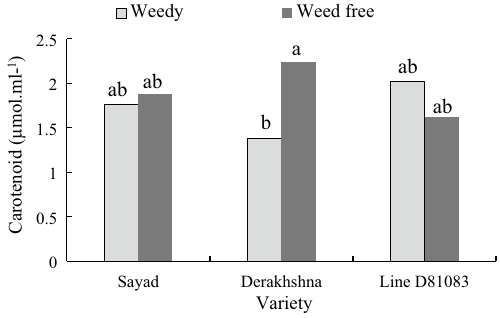
Figure 12. The carotenoid content in two treatments weedy and weed free, in the three cultivars/lines studied and in two stages of sampling V4 and